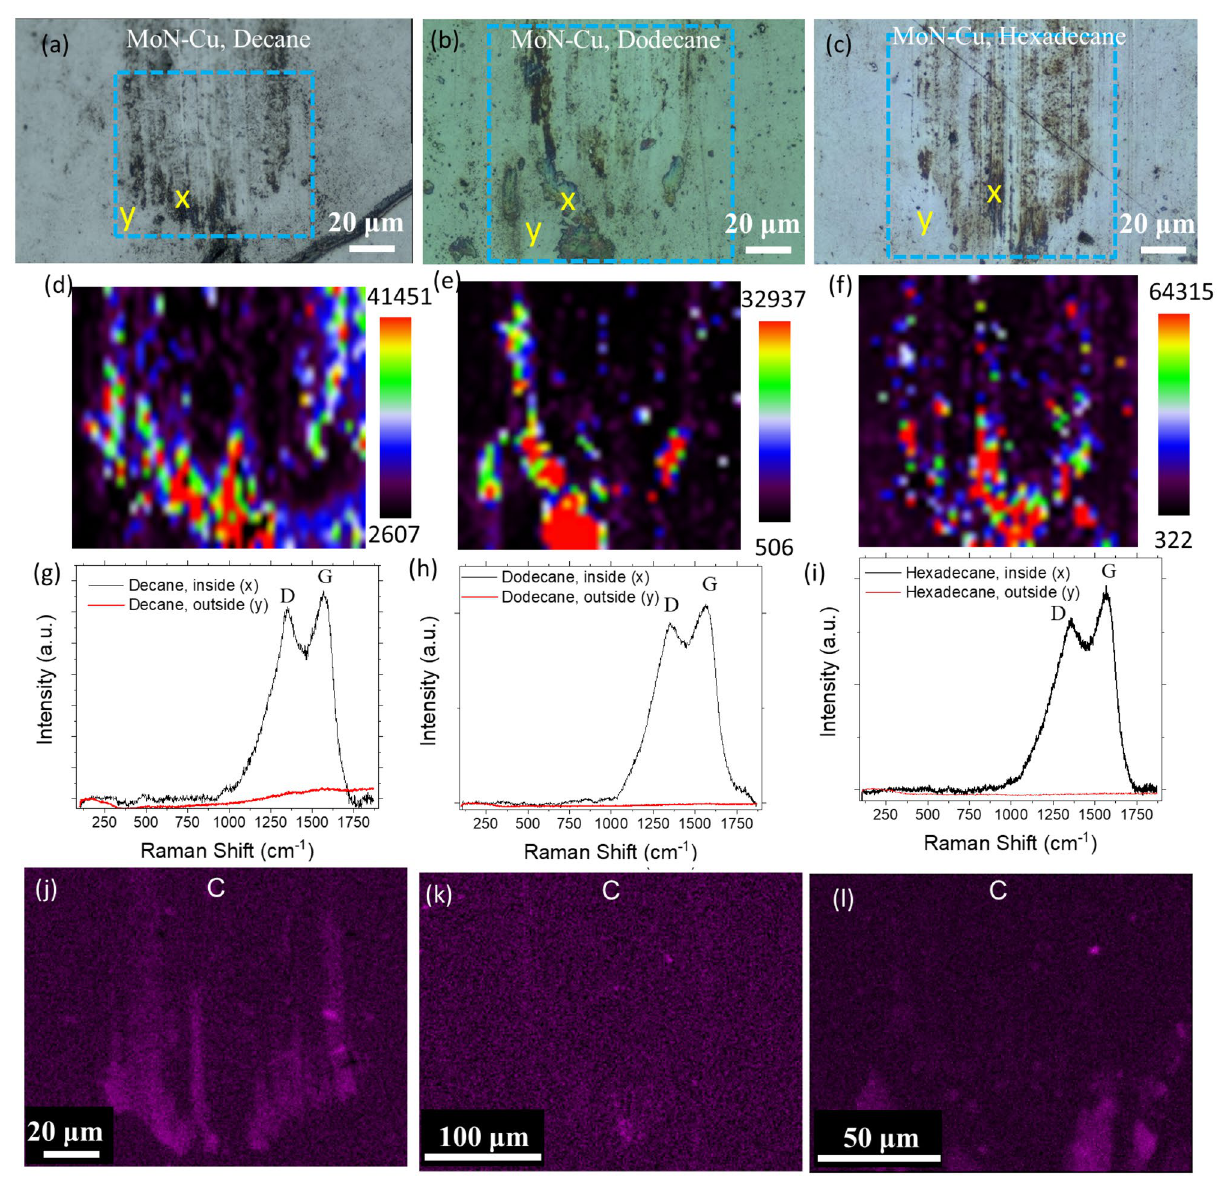
Figure 5. Optical micrographs of the wear tracks, 2D-Raman mapping of carbon G peak (at ~ 1560 cm -1 ) in the area highlighted with a blue dashed line, and Raman spectra for two points inside and outside of the wear tracks formed on MoN-Cu coating in ( a , d , g ) decane, ( b , e , h ) dodecane, and ( c , f , i ) hexadecane solutions, respectively, at 1 N applied load and 50 °C. EDS C elemental mapping of MoN-Cu wear tracks produced during the tribology tests at 1 N and 50 °C in ( j ) decane, ( k ) dodecane, and ( l )